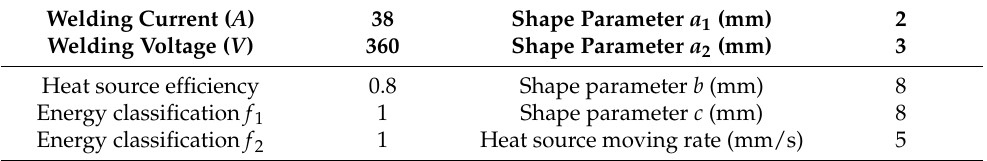
Table 3. Welding heat source parameter.